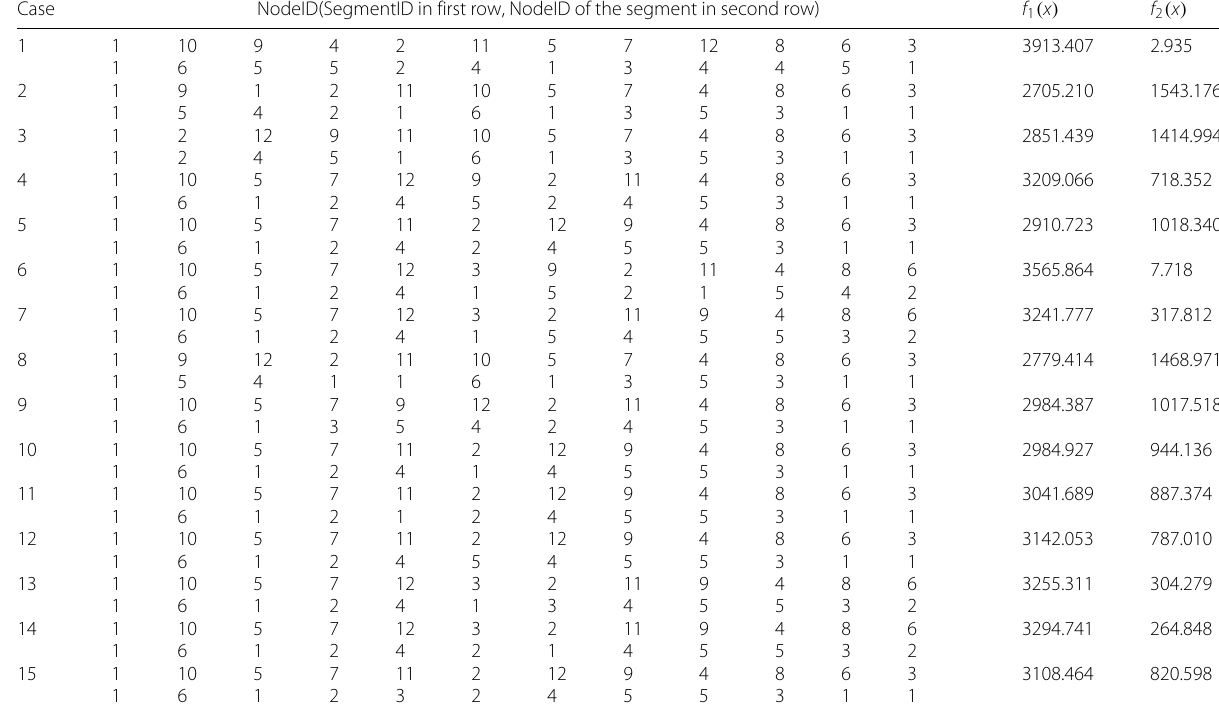
Table 4 Some experimental results of the 10ch150.tsp instance when